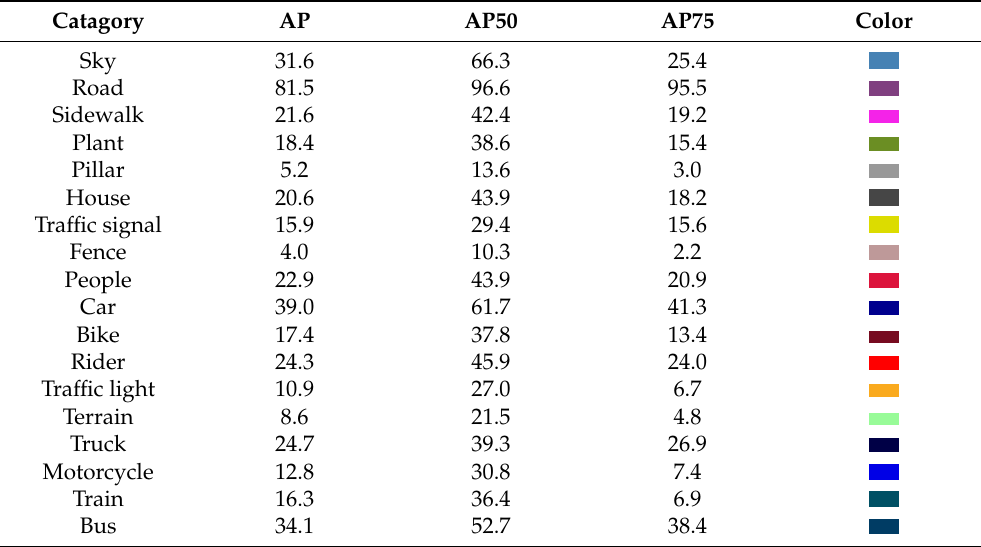
Table 1. Recognition accuracy of objects in